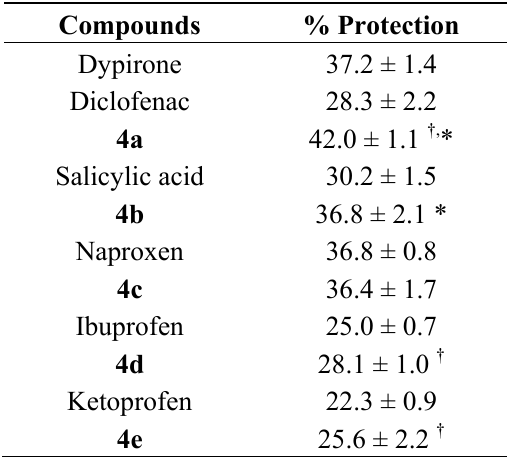
Table 2. Antinociceptive effect of dypirone, compounds ( 4a – e ), and parent NSAIDs using acetic acid-induced abdominal constrictions.